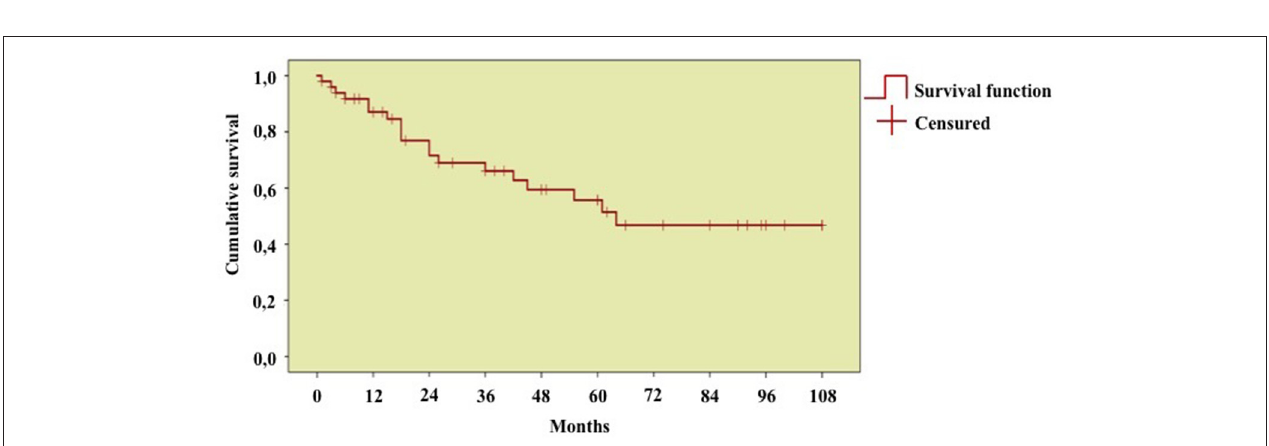
FIGURE 8 | Long-term drug retention rate of biologic treatment courses. Kaplan-Meier survival curve describing the overall drug retention rate assessed on 55 treatment courses. Time 0” corresponds to the start of biologic courses and the “event” represents the discontinuation of therapy because of primary or secondary inefficacy, adverse events, or lack of